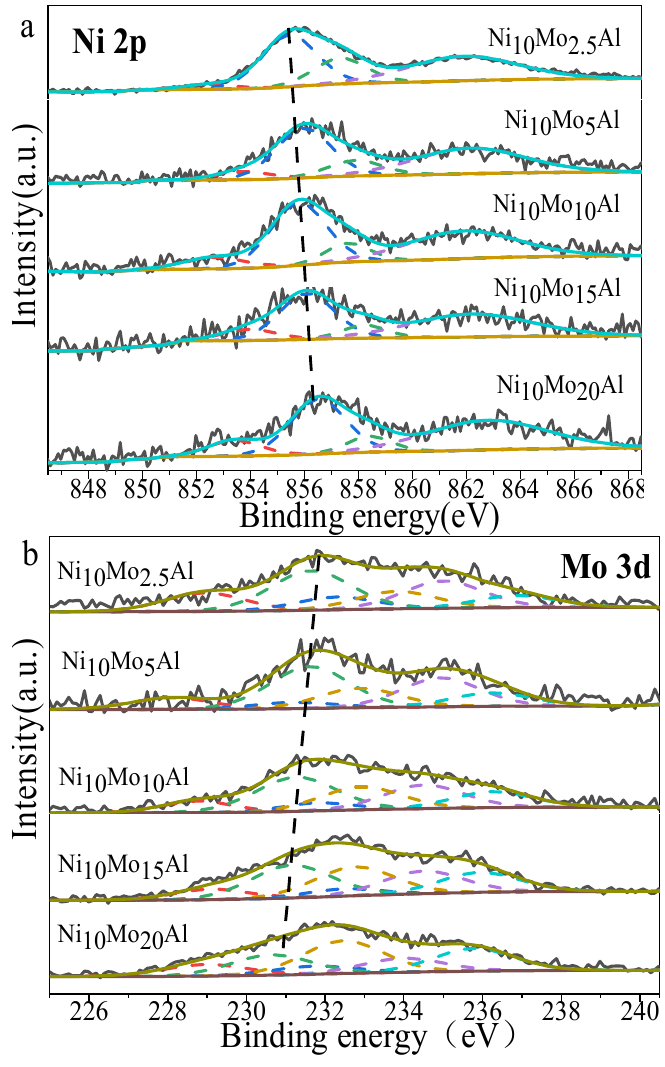
Figure 8. XPS spectra of Ni2p ( a ) and Mo3d ( b ) of Ni 10 Mo x Al catalysts reduced at 450 °C. Table 3. Quantitative Ni 2p and Mo 3d XPS analysis for Ni 10 Mo x Al catalysts a .